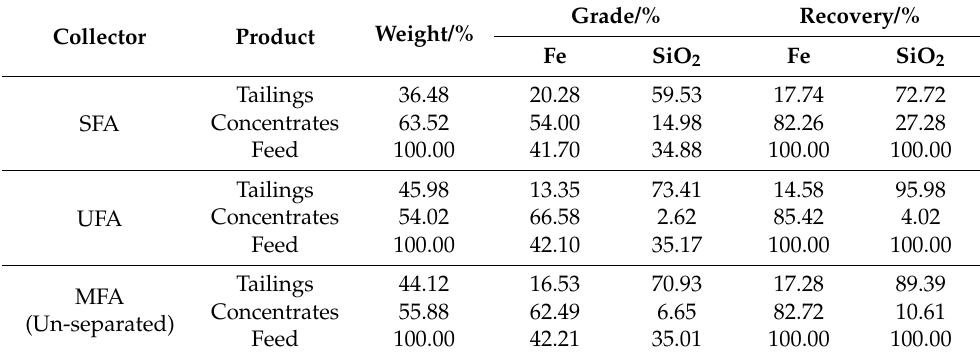
Table 4. Results of bench-scale